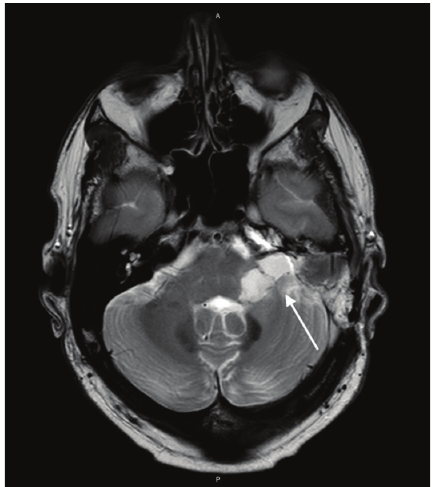
Figure 6: Axial MR image (T2 weighted) showing the postoperative